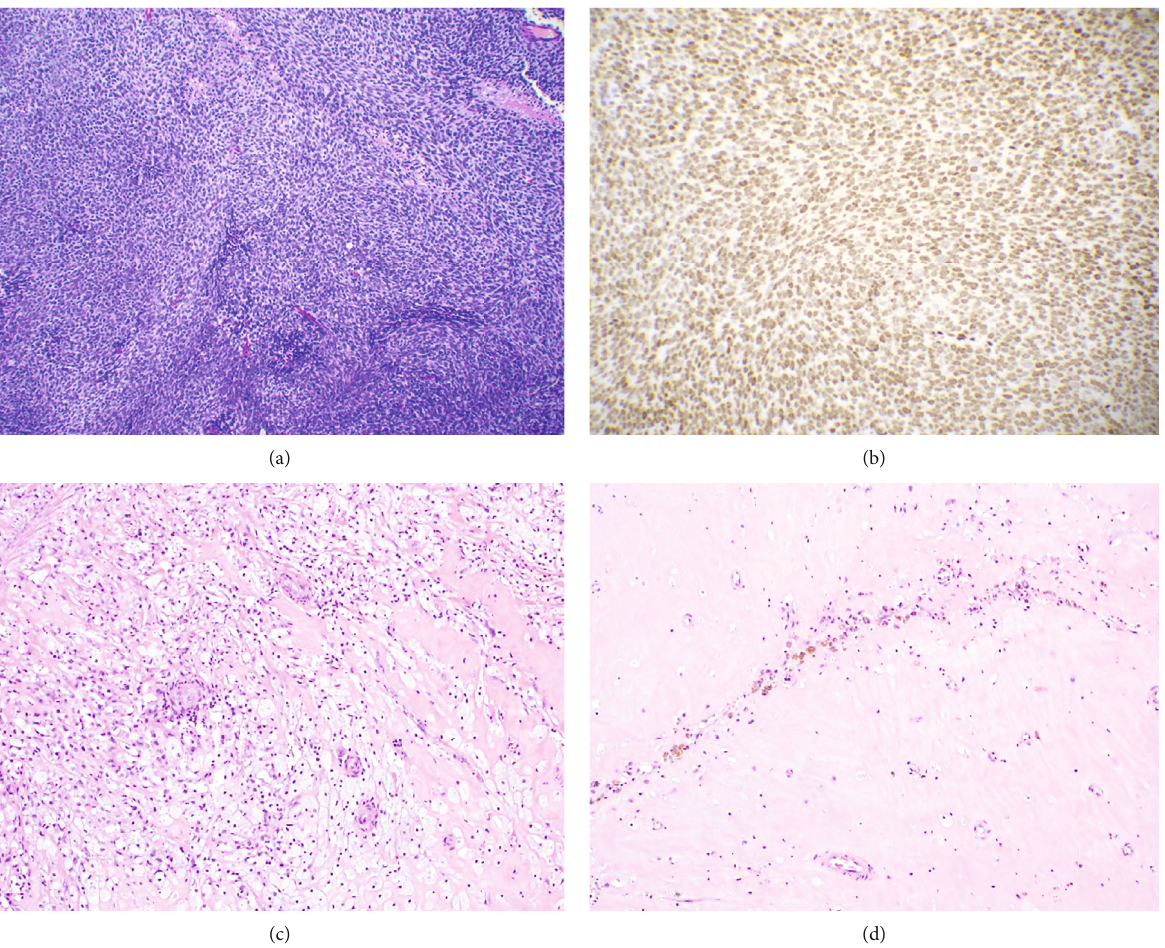
Figure 2: Histology of synovial sarcoma case. Diagnostic biopsy (a) demonstrated proliferation of spindle to epithelioid cells of monomorphic appearance with elongated nuclei and scant cytoplasm arranged in a whorled “ herringbone ” architecture (Hematoxylin and Eosin, 100x). Fli-1 immunohistochemistry (b) demonstrated strong, di ff use nuclear staining, con fi rming the diagnosis (200x). The posttreatment resection specimen demonstrated substantial treatment e ff ected with the majority of residual tumor mass now comprised of areas of histiocytic in fi ltration (c) fi brosis, pigment deposition, and chronic in fl ammation (d) (Hematoxylin and Eosin,